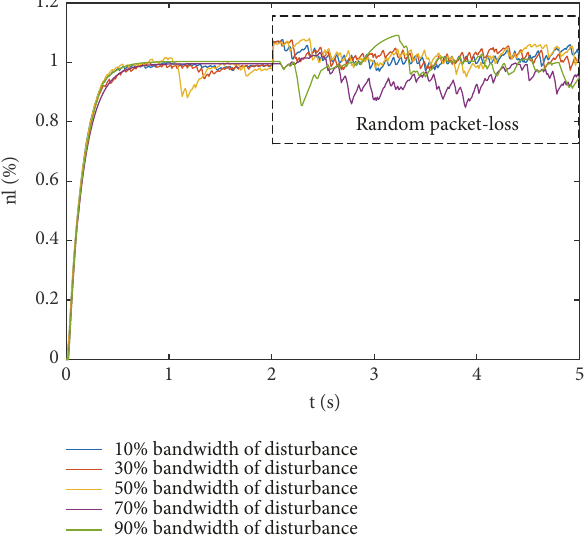
Figure 6: Simulation results with the presence of disturbances and random